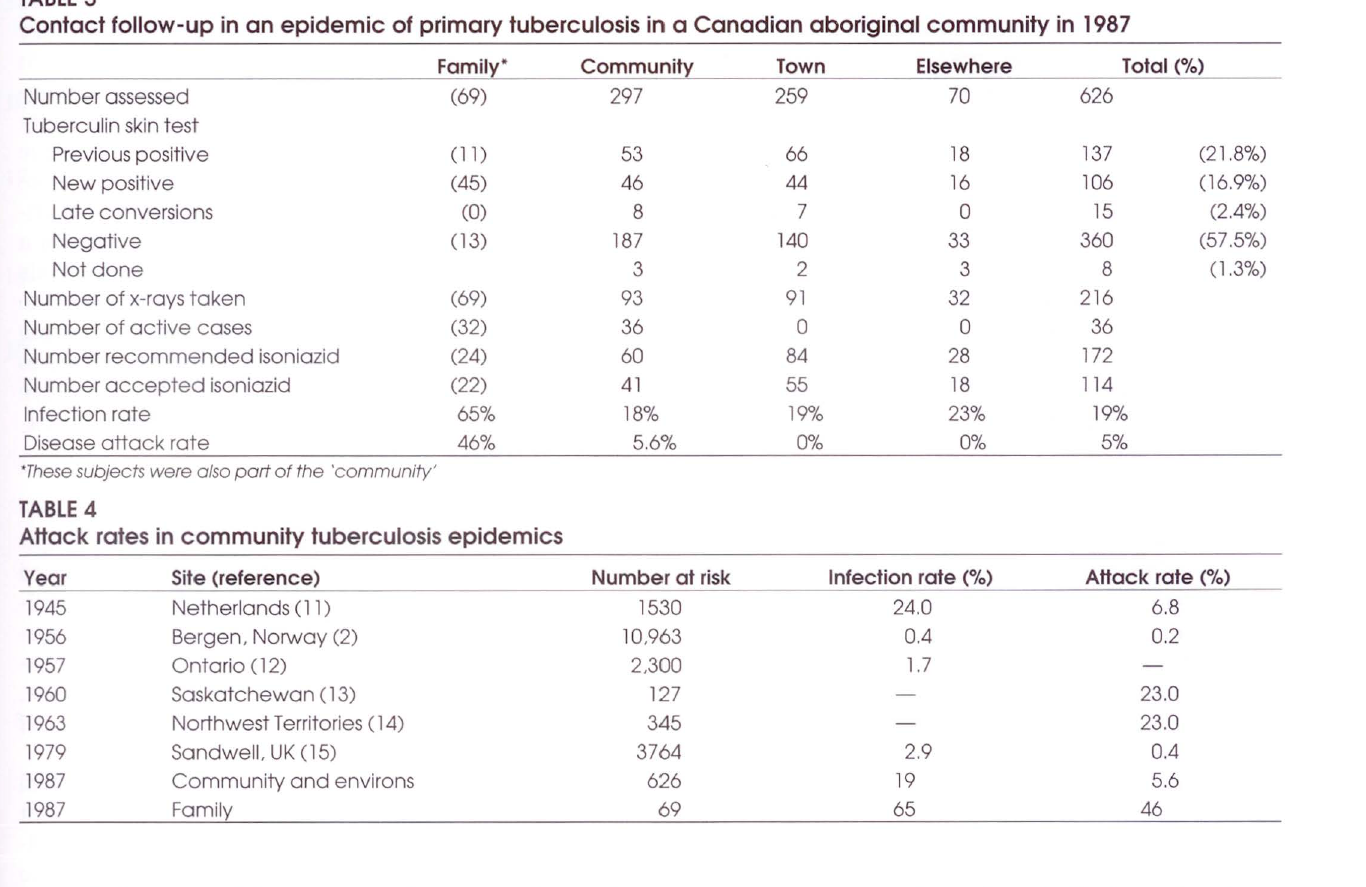
Contact follow-up in an epidemic of primary tuberculosis in a Canadian aboriginal community in 1987 Family*